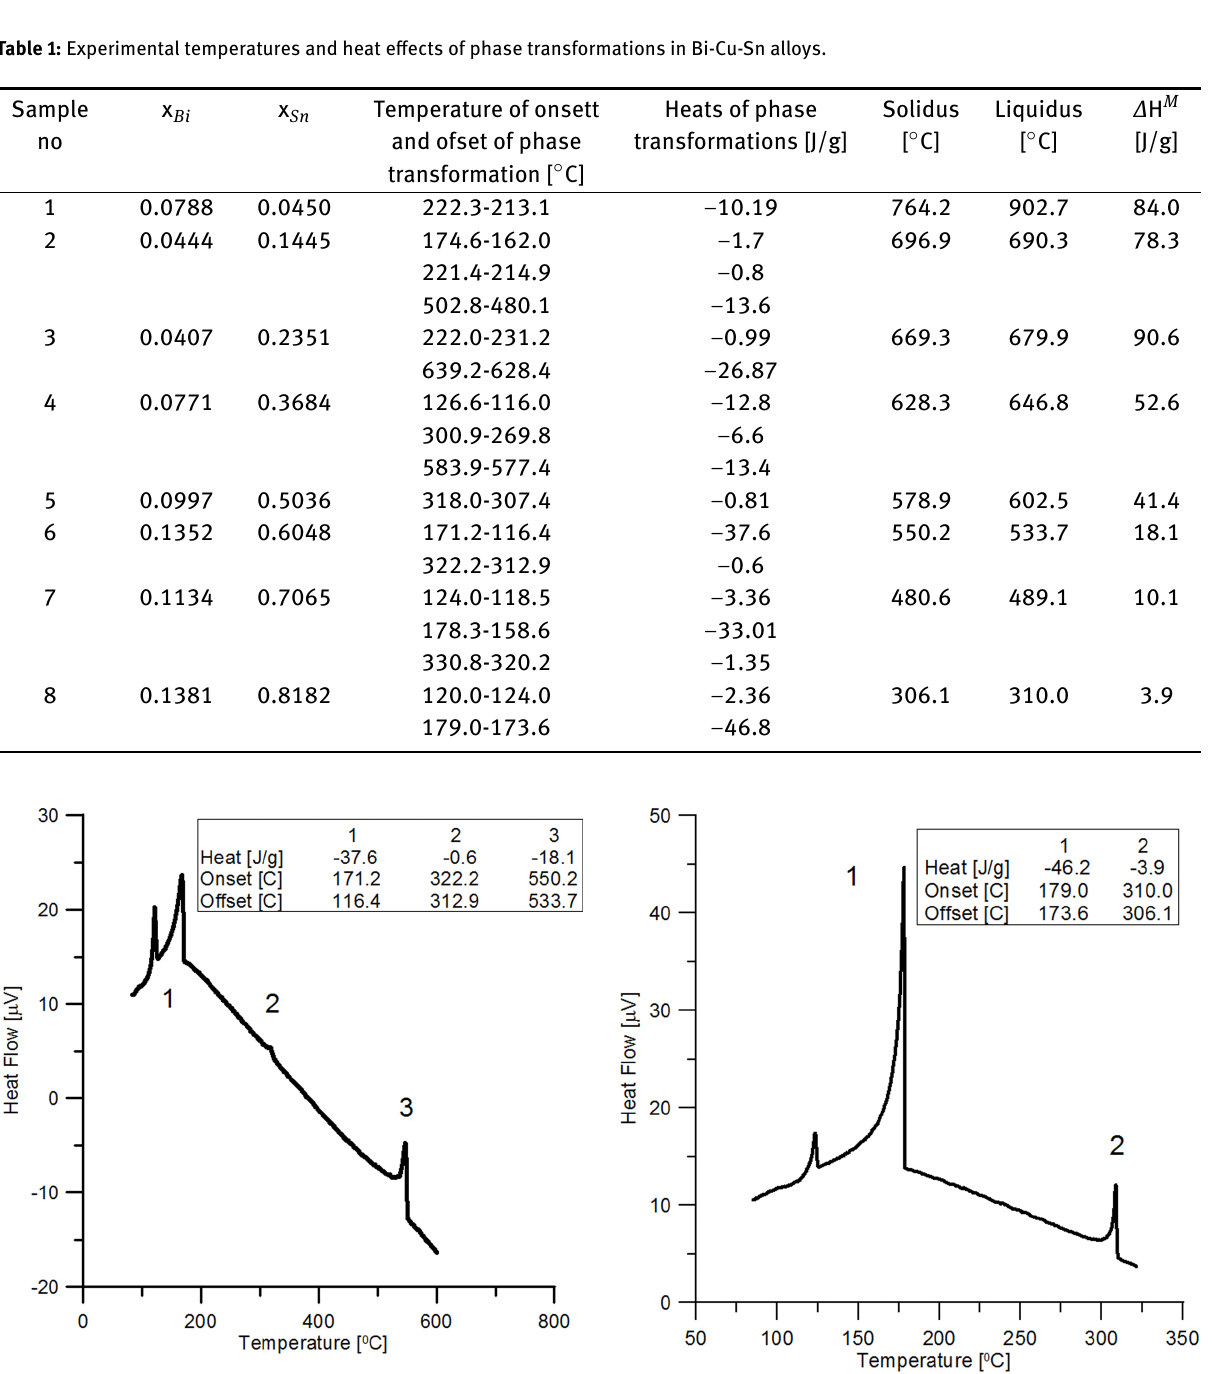
Figure 4: DSC curve of the alloy no 6.